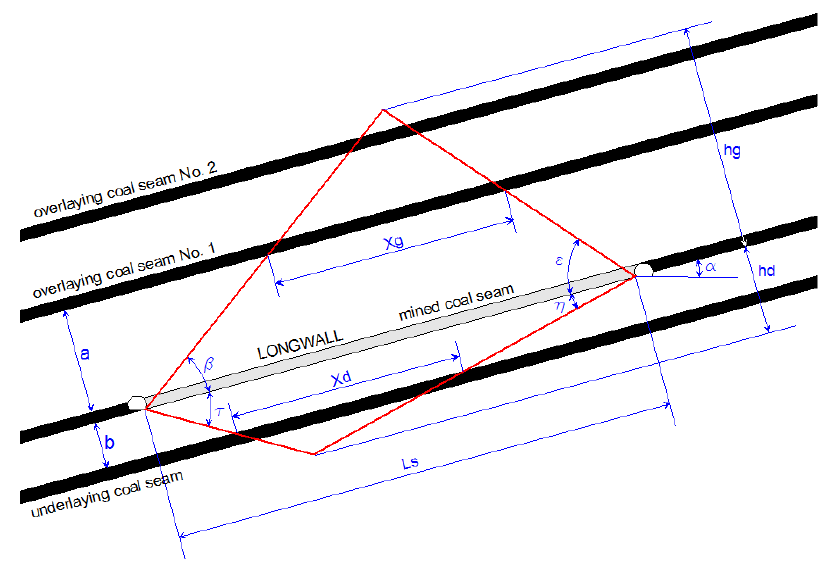
Figure 1. Section through a methane desorption zone from a destressed mined longwall [10]. According to the empirical method, the ranges of the upper and lower destressing zones (desorption zones) depend on the longwall length ( L s ) and the longwall inclination angle ( a ). The ranges are defined using Equations (1) and (2):